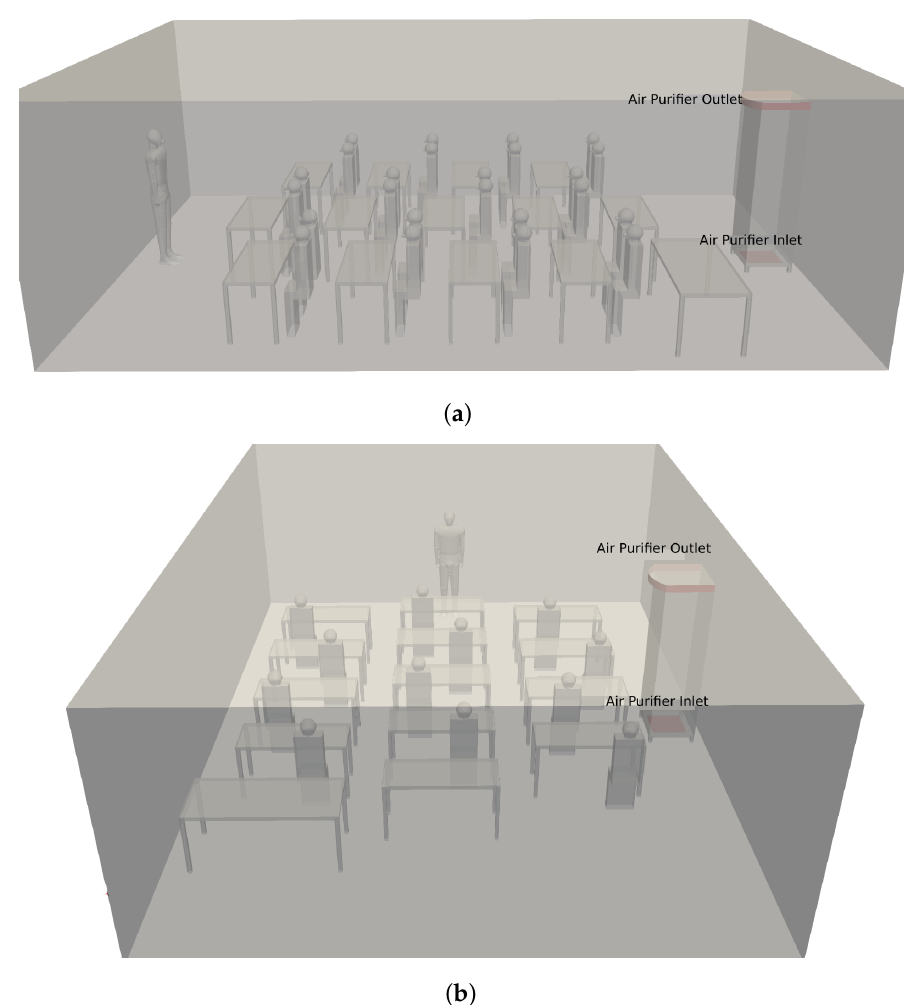
Figure 1. The basic geometry of the classroom with ( a ) the AP on the short side of the room operating at full capacity (24 students + 1 teacher). ( b ) AP on the long side of the room operating at half capacity (12 students + 1